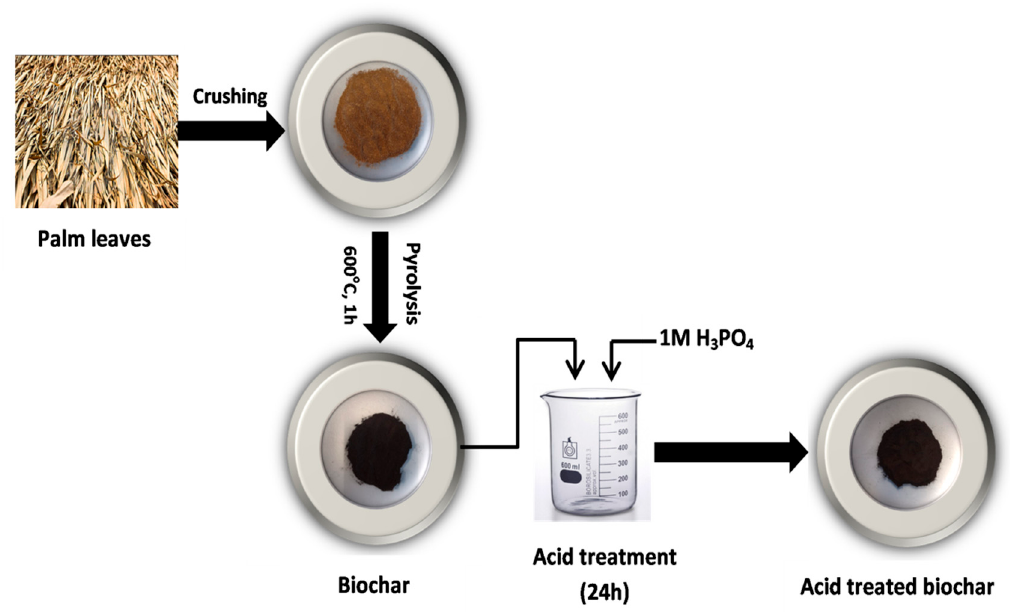
Figure 1. Schematic representation for the preparation of the TBC-P.